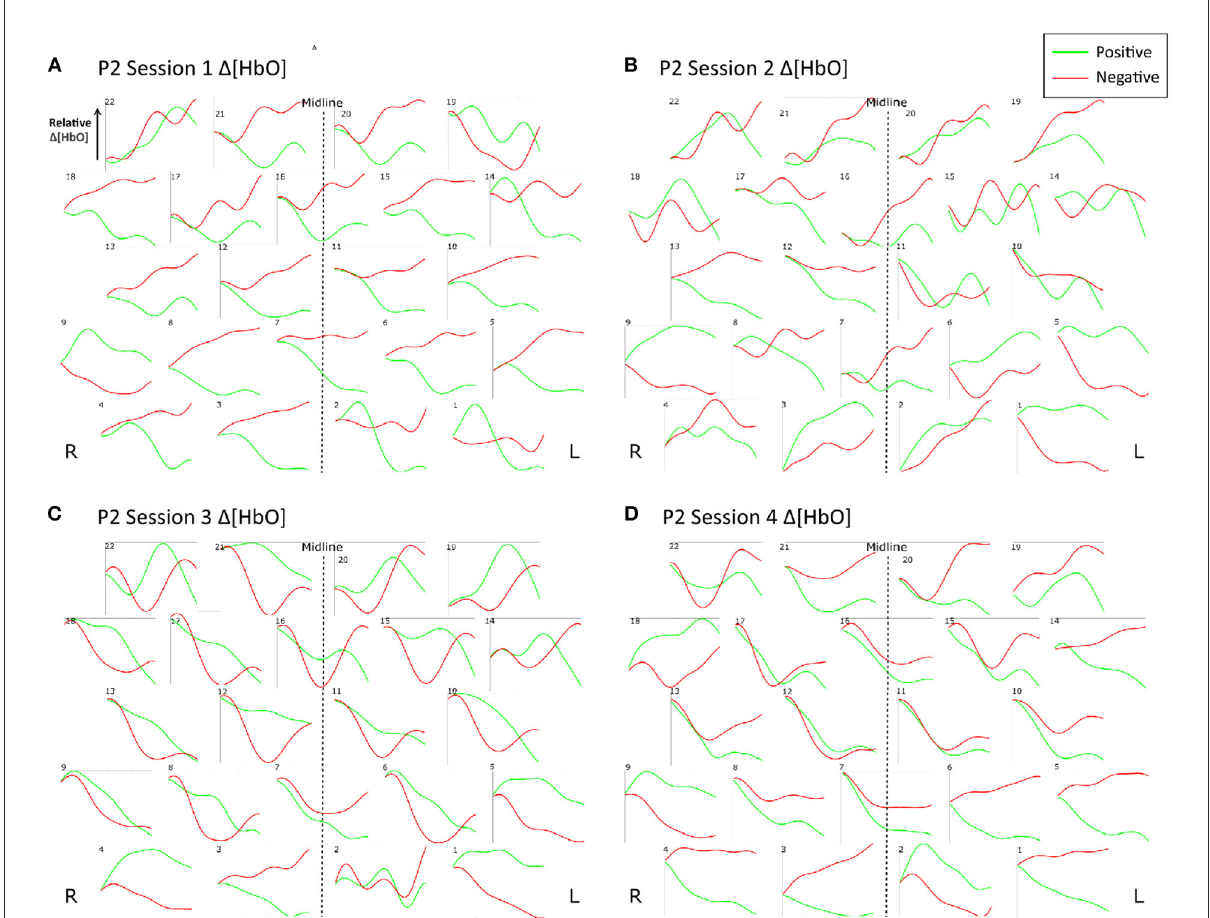
FIGURE10 Trial-averaged hemodynamic response functions ( 1 [HbO]) for P2 for all four sessions. (A) 1 [HbO] for Session 1, (B) 1 [HbO] for Session 2, (C) 1 [HbO] for Session 3, and (D) 1 [HbO] for Session 4. The response function for each channel is shown mapped according to its position over the forehead. The lighter shade (green) indicates the average of all positive trials, and the darker shade (red) indicates the average of all negative trials from the respective